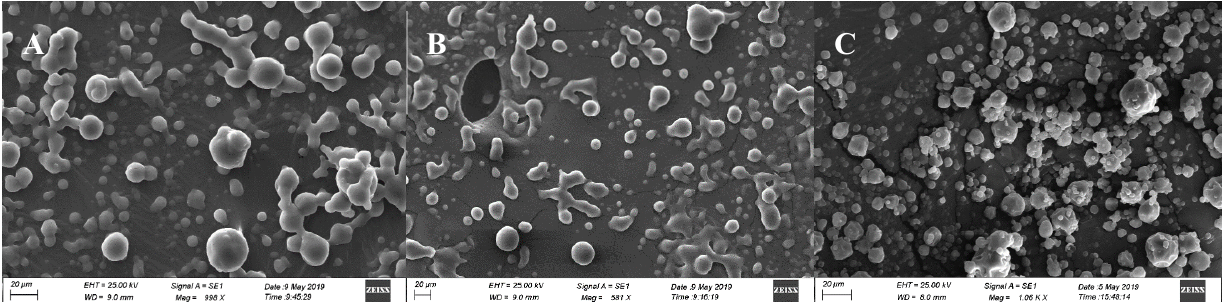
Scheme 1. Effect of particle size on the parameters of the Avrami equation for the spray-dried pow-